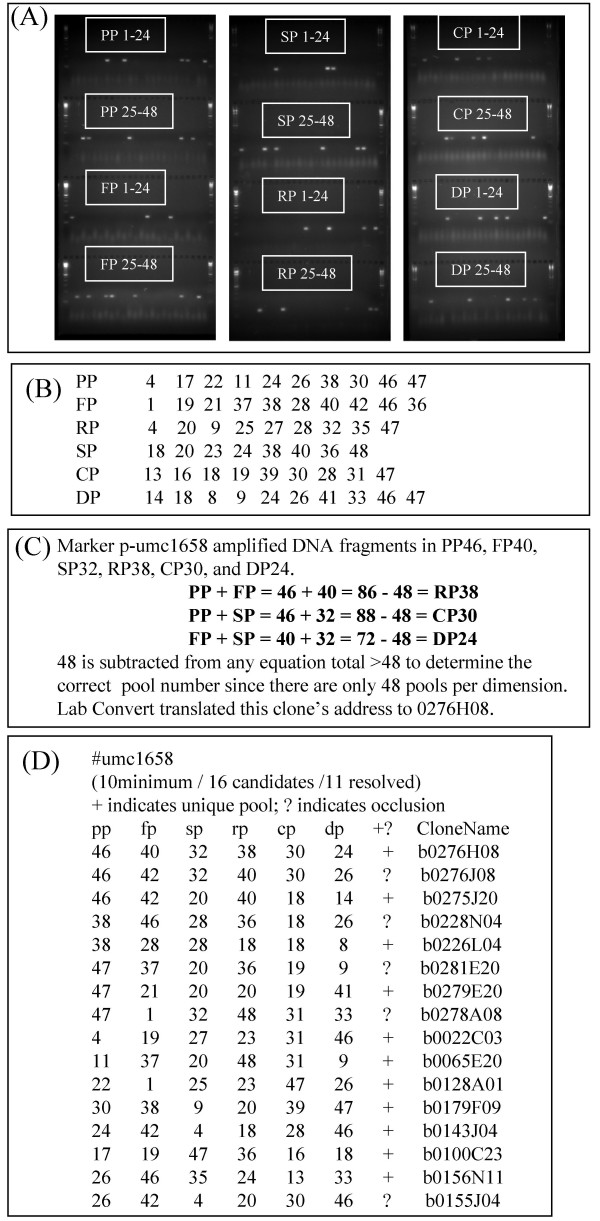
Representative gel images of BAC pool screening. Primers for umc1658 were used to amplify pool DNA. On average 6 positives per dimension are expected. Amplified PCR products were electrophoresed on 4.5% Super Fine Resolution Agarose gels (A). Each gel contained two dimensions of BAC pools, first gel with plate (PP) and face (FP) pools, second gel with side (SP) and row (RP) pools, and the last gel on the right with column (CP) and diagonal (DP) pools. First and last lane of each tier contains 100 bp ladder. Electrophoresed gel images were scored in tab delimited text format (B). Amplified products were deconvoluted by Resolve script using 3 equations (C). BAC addresses were automatically converted using Lab Convert software (D).